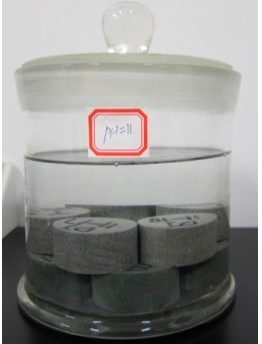
Figure 1. Sandstone corroded specimens.